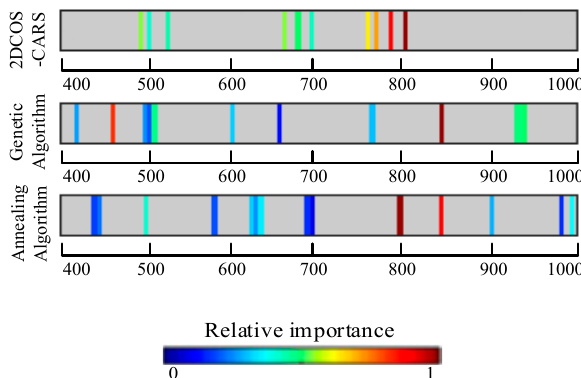
Figure 11. Wavebands extracted by the three methods. Remote Sens. 2020 , 12 , x FOR PEER REVIEW